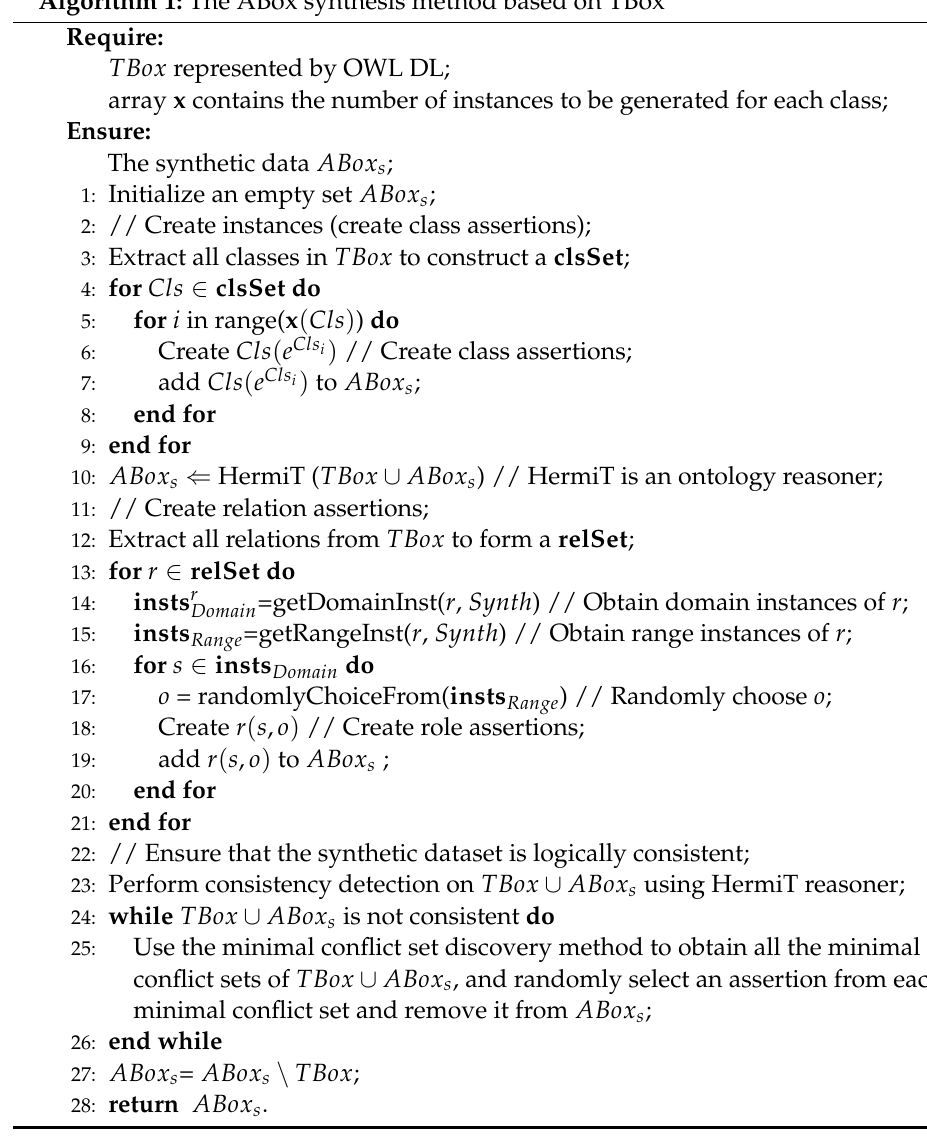
Algorithm 1: The ABox synthesis method based on